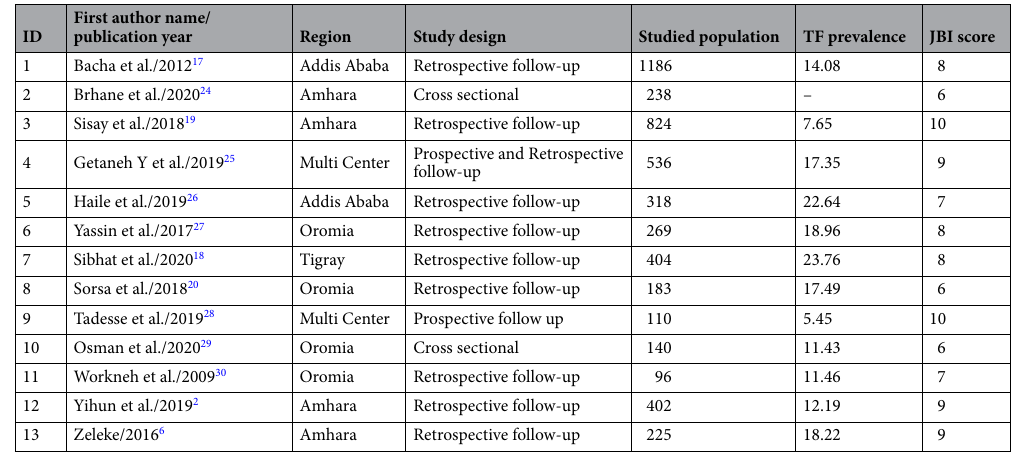
Table 1. Characteristics of original studies on first line ART failure among children in Ethiopia, 2020. TF- Treatment Failure. – denotes no estimation due to lack of information from the original studies.